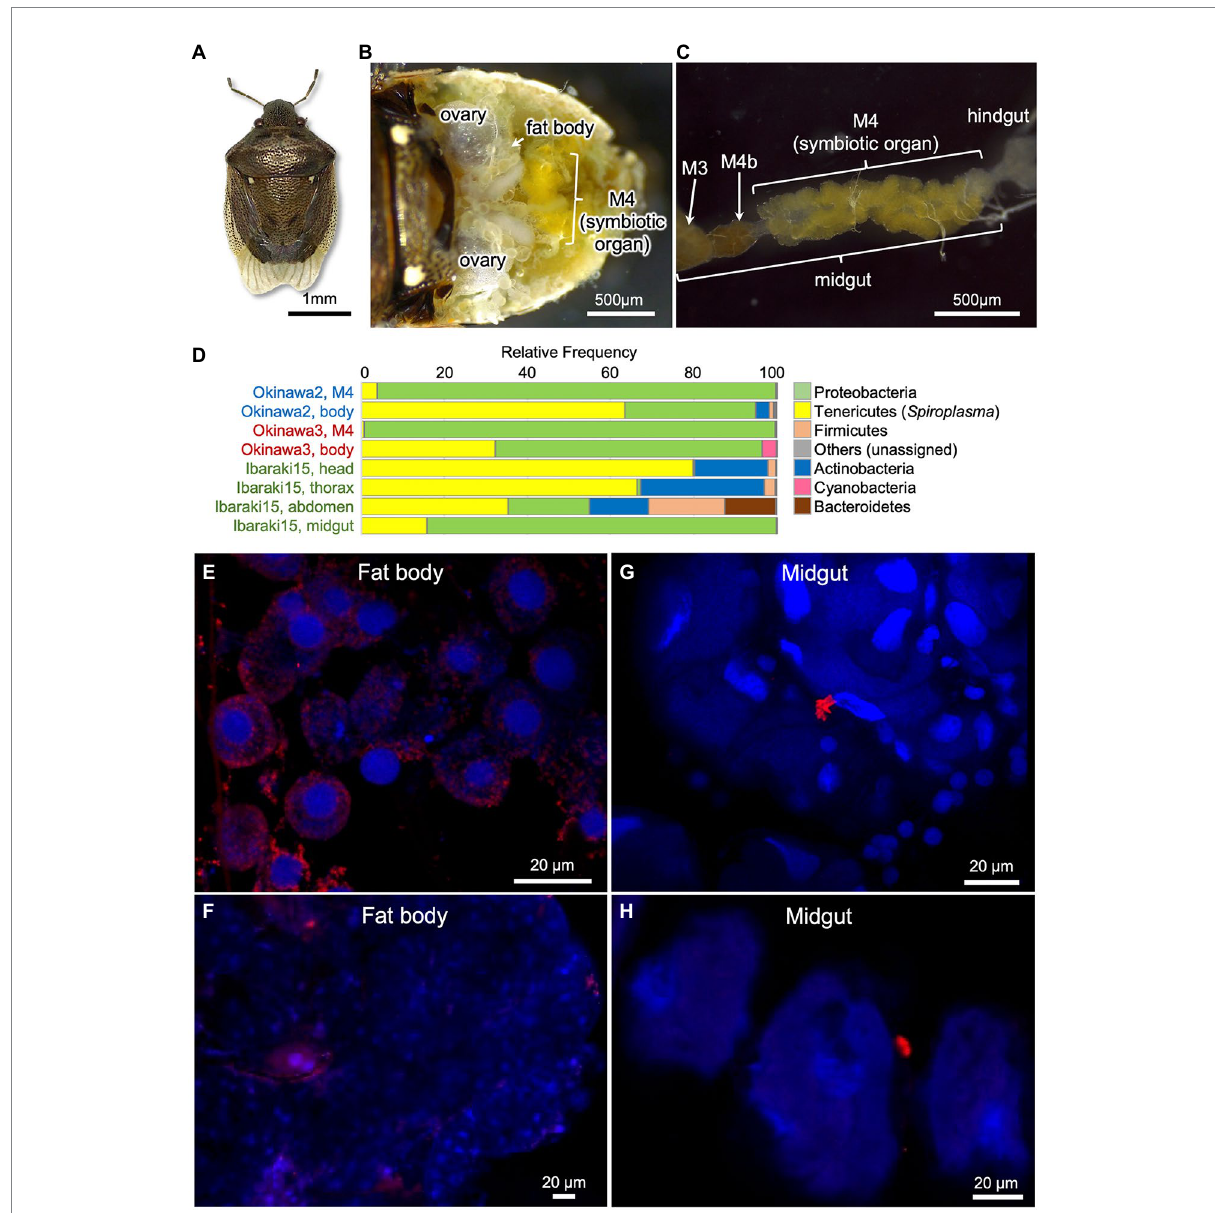
FIGURE 3 Spiroplasma symbiont associated with the white-spotted stinkbug Eysarcoris ventralis . (A) An adult insect. (B) Dissected abdomen. (C) Isolated alimentary tract. Abbreviations: M3, midgut third section; M4, midgut fourth section as the symbiotic organ; M4b, bulb-like section connected to M4 (see Oishi et al., 2019; Moriyama et al., 2022). (D) The relative abundance of the top seven bacterial phyla detected from three individuals of E. ventralis by 16S rRNA gene amplicon sequencing. The phylum Tenericutes (or Mycoplasmatota) corresponds to Spiroplasma . The sample names in the same color indicate those derived from the same insect individual. (E–H) FISH localization of Spiroplasma symbiont in fat body (E,F) and midgut symbiotic organ (G,H) of E. ventralis . (E,F) represent images derived from different individuals, so do (G,H) . Red signals represent Spiroplasma cells visualized by FISH whereas blue signals show insect nuclear DNA visualized by DAPI